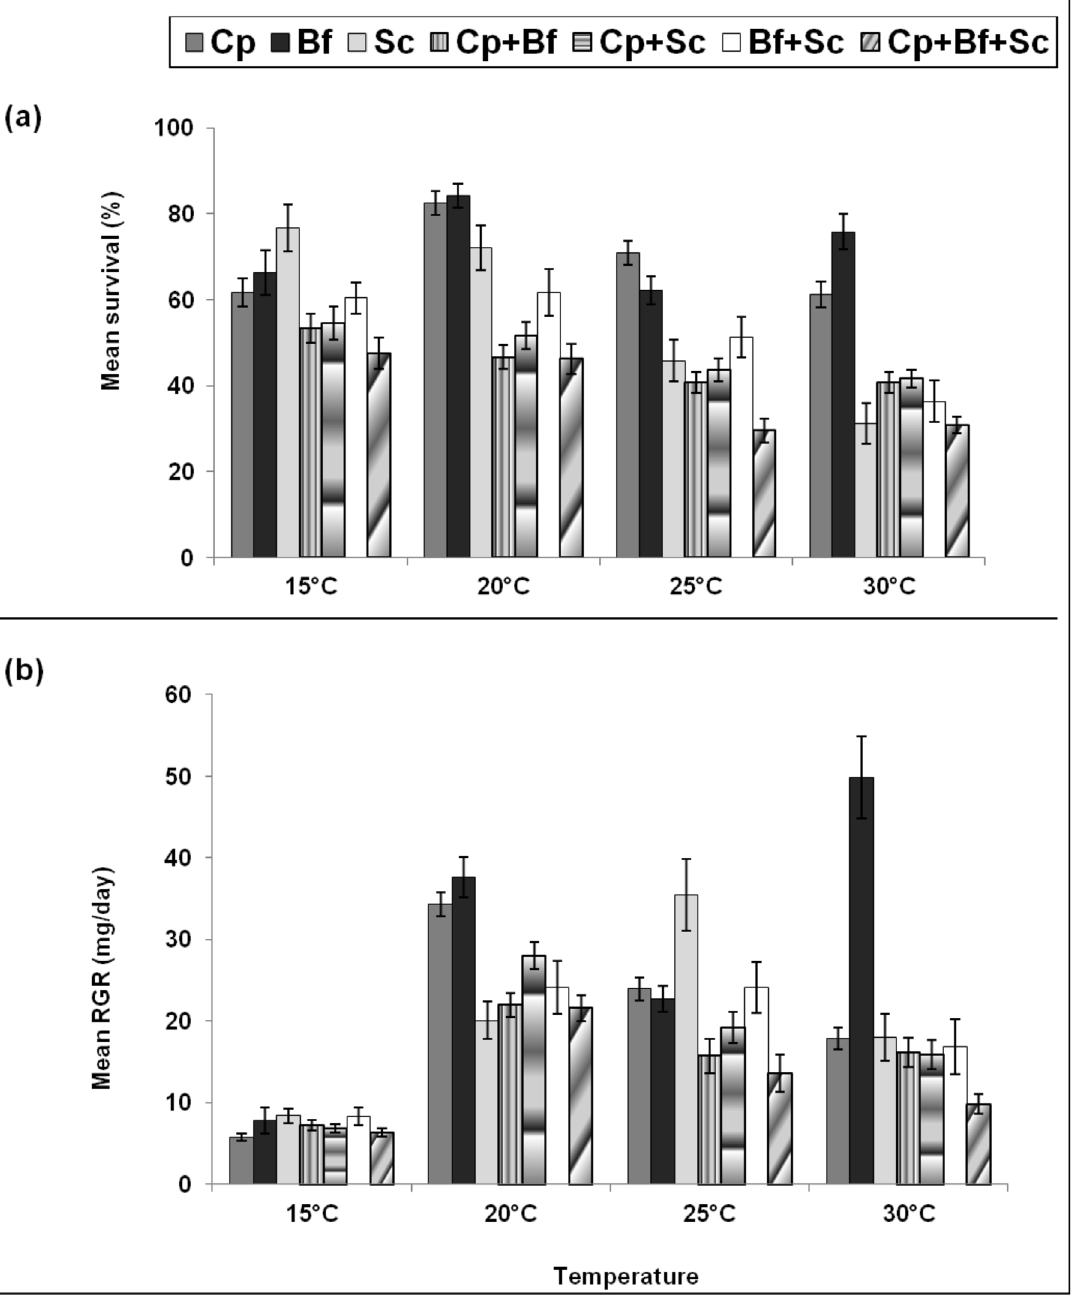
Fig 6. Comparative survival (a) and RGR (b) between single-species and multi-species communities of Chilo partellus (Cp), Busseola fusca (Bf) and Sesamia calamistis (Sc) under different constant temperatures . Statistical comparisons were only made between single- and the corresponding multi-species pairings (see Tables 5 and